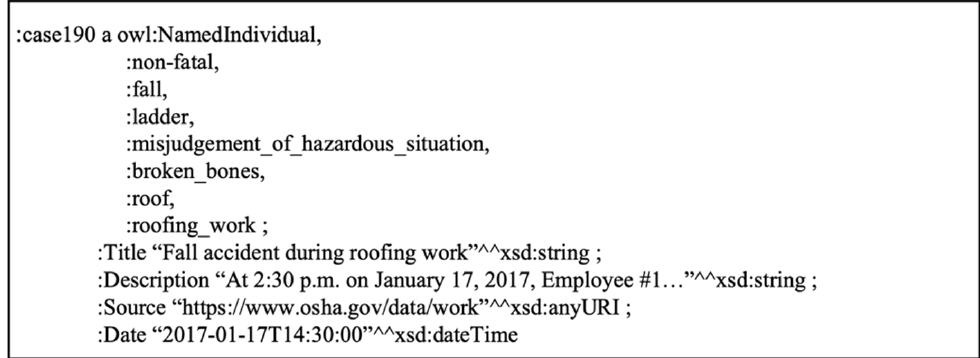
Figure 6. Accident case in the Turtle serialization.